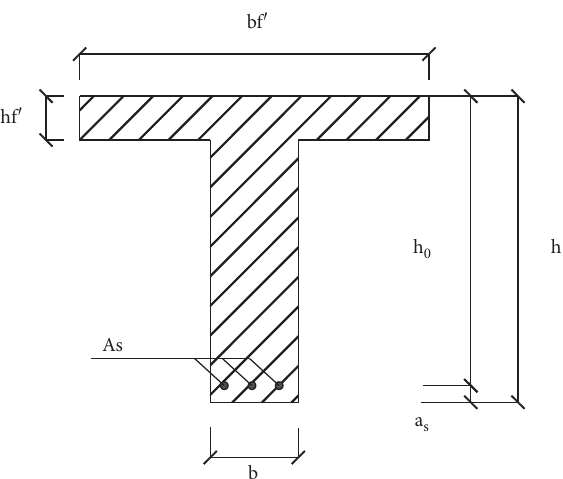
Figure 3: T-shaped section in engineering